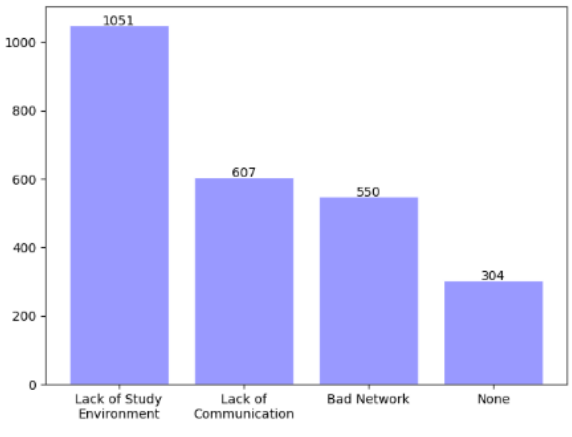
Figure 4. Negative factors.